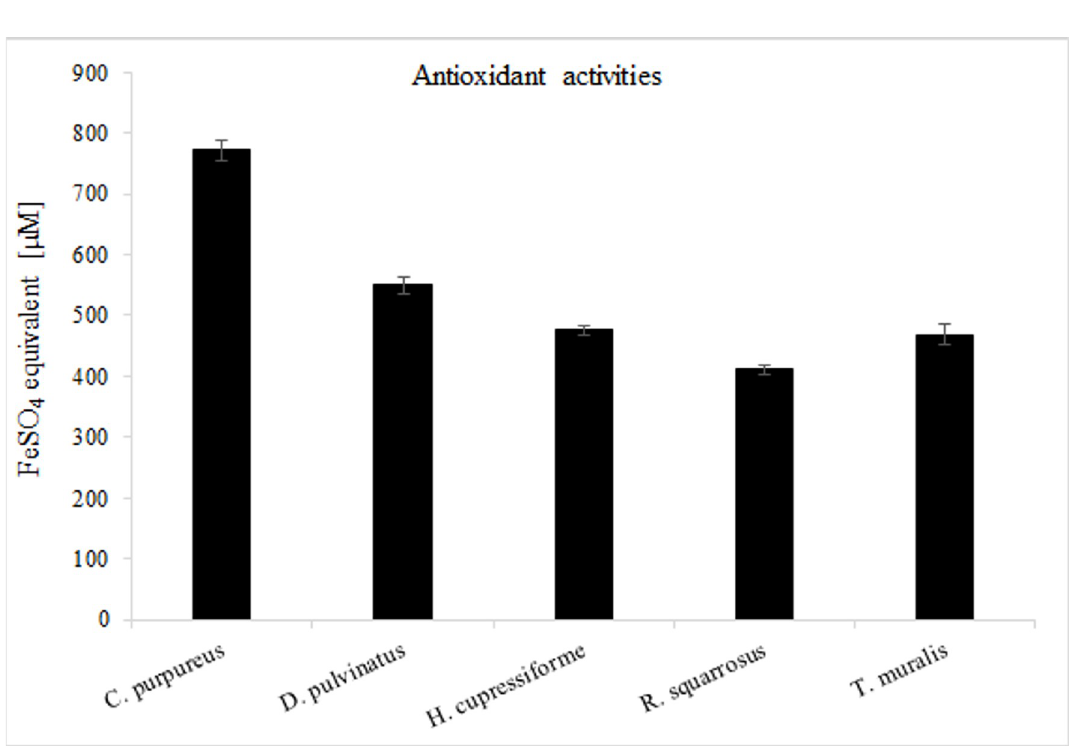
Fig 4. Reducing antioxidant power of mosses extracts calculated as FeSO 4 equivalent [ μ M]. The results are expressed as mean values of 3 independent experiments ± SD. https://doi.org/10.1371/journal.pone.0257479.g004 PLOS ONE | https://doi.org/10.1371/journal.pone.0257479 September 20,